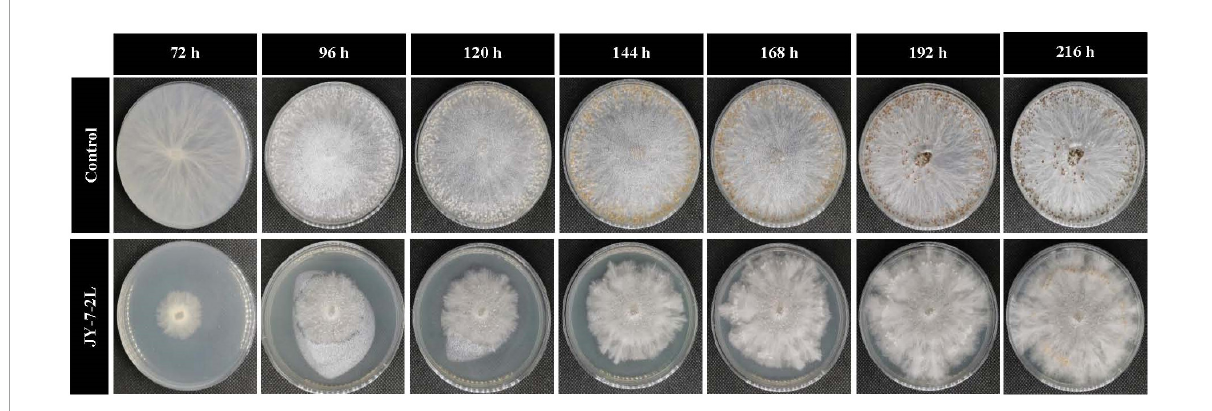
with B. subtilis JCM 1465 T sharing 100% similarity in the phylogenetic tree based on the 16S rRNA gene sequence ( Figure 1B ). Single housekeeping gene-based phylogenetic trees showed the same result with MLSA, where JY-7-2L clustered together with B. subtilis (97.4% similarity in MLSA) ( Figure 1C and Supplementary Figures 1 – 3 ). Taken together, JY-7-2L was identified as B. subtilis .